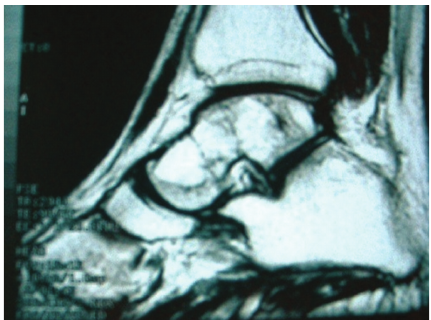
Figure 2: Fat containing cystic lesions surrounded by smooth, thick rims with septations in both talus have been shown on MRI.